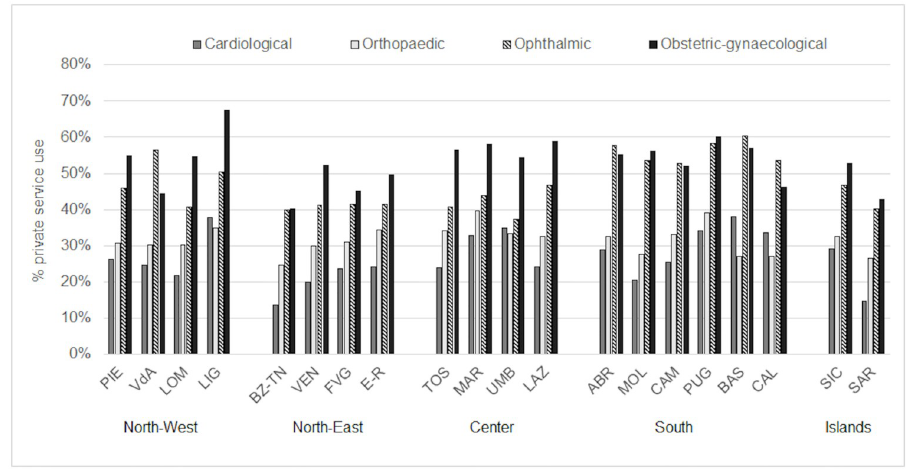
Fig 1. Private use rate for cardiologic, orthopedic, ophthalmic and obstetric-gynecological visits, across Italian regions (2013). PIE, Piedmont; VdA, Aosta Valley; LOM, Lombardy, LIG, Liguria; BZ-TN, Trentino-South Tyrol; VEN, Veneto, FVG, Friuli-Venezia Giulia; E-R, Emilia-Romagna; TOS, Tuscany, MAR, Marche, UMB, Umbria; LAZ, Lazio; ABR, Abruzzo, MOL, Molise, CAM, Campania, PUG, Apulia, BAS, Basilicata; CAL, Calabria; SIC, Sicily; SAR,